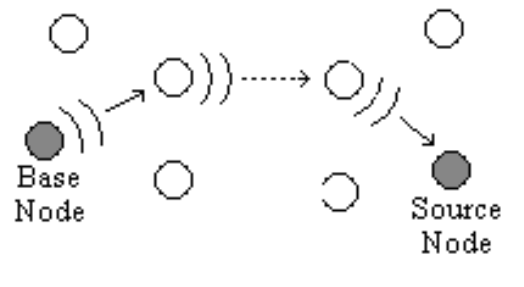
Figure 5. Transmission an acknowledgement